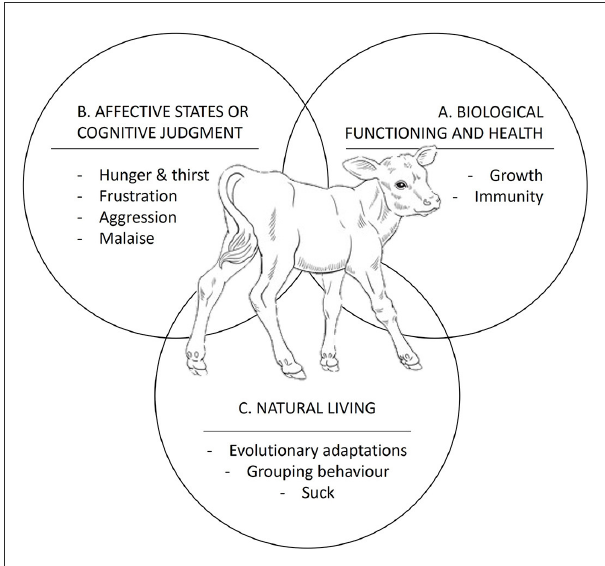
FIGURE1 The three spheres of animal welfare and corresponding keywords: (A) biological functioning and animal health, (B) affective states or cognitive judgement, and (C) natural living (Adapted from